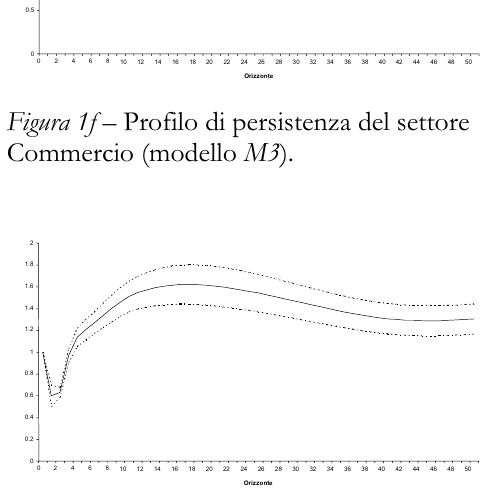
Figura 1g – Profilo di persistenza del settore Trasporti (modello M3 ).